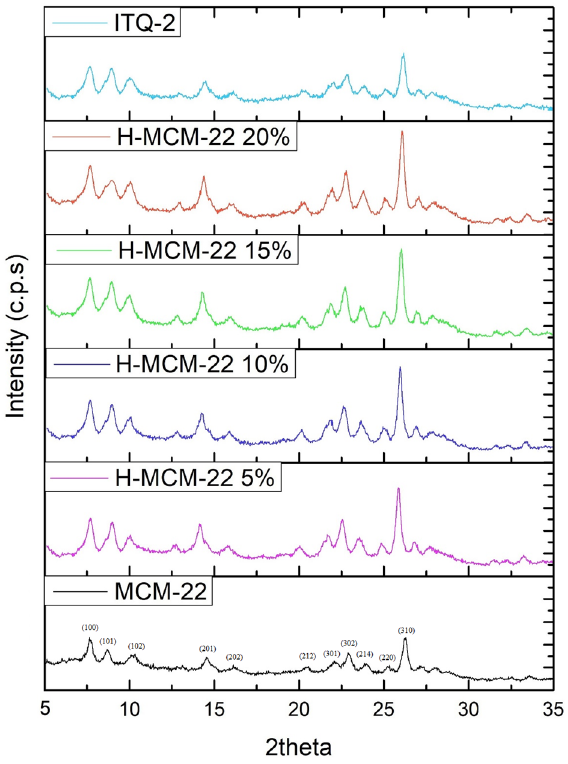
Figure 2. XRD patterns of ITQ-2, MCM-22, H-MCM-22 5%, H-MCM-22 10%, H-MCM-22 15%, and H-MCM-22 20%